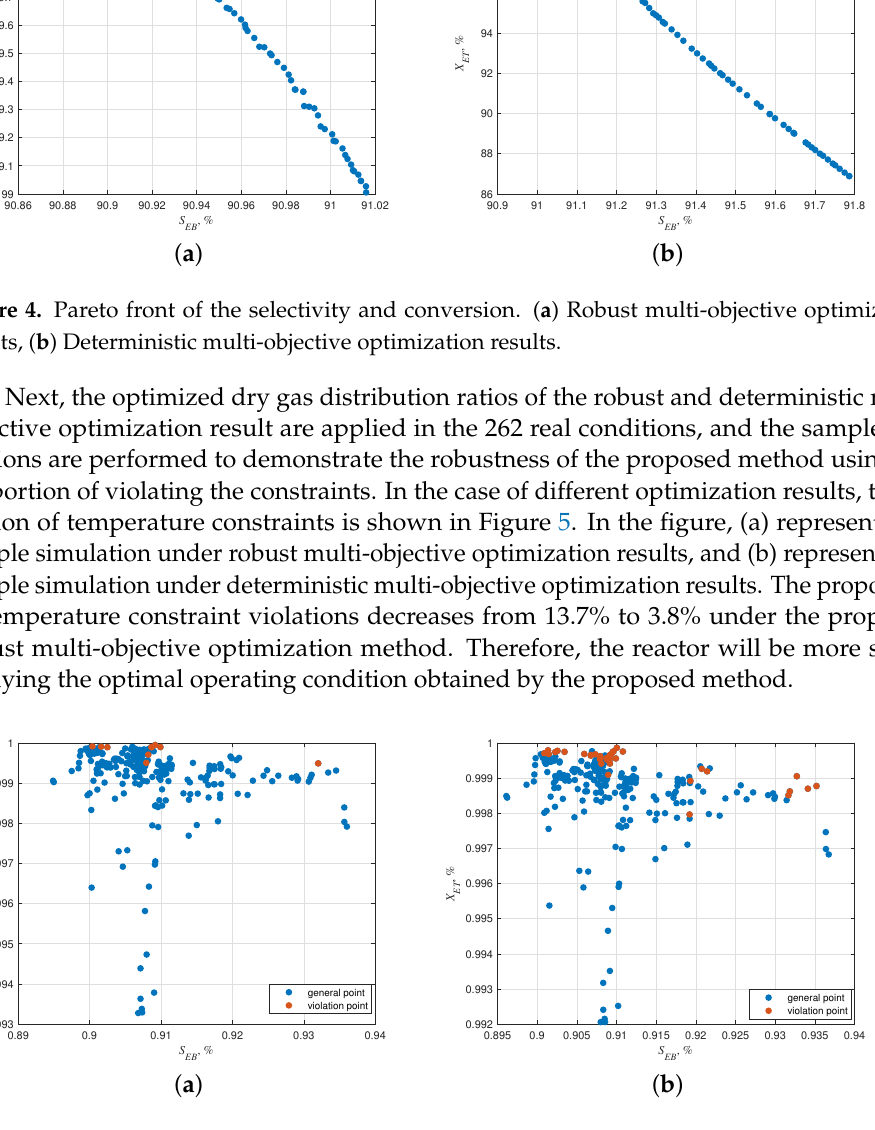
Figure 5. The sample simulation under different results. ( a ) Cases under robust multi-objective optimization results, ( b ) cases under deterministic multi-objective optimization